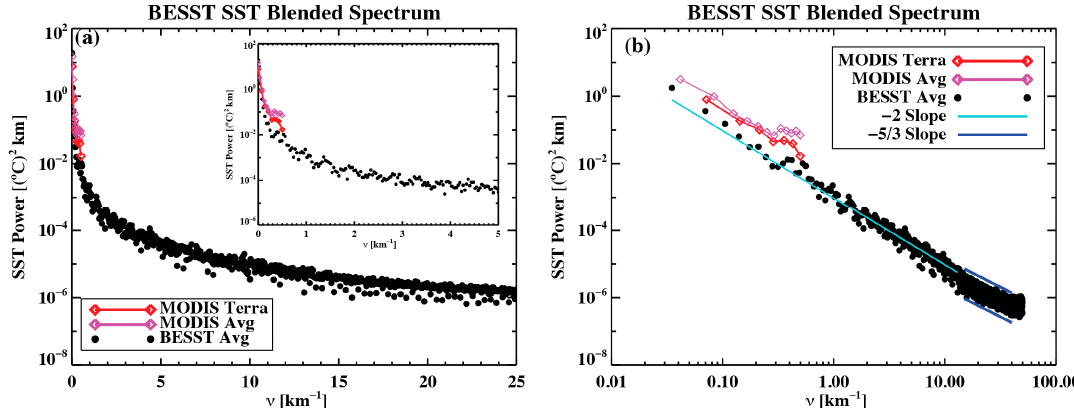
Figure 9. Blended BESST wavenumber spectrum over the entire survey domain. ( a ) Semi-log spectrum with the inset highlighting the range from 0–5 km − 1 ; ( b ) Corresponding log–log spectrum along with overlays of spectral slopes of − 2 and − 5/3 in the light and dark blue colors, respectively.